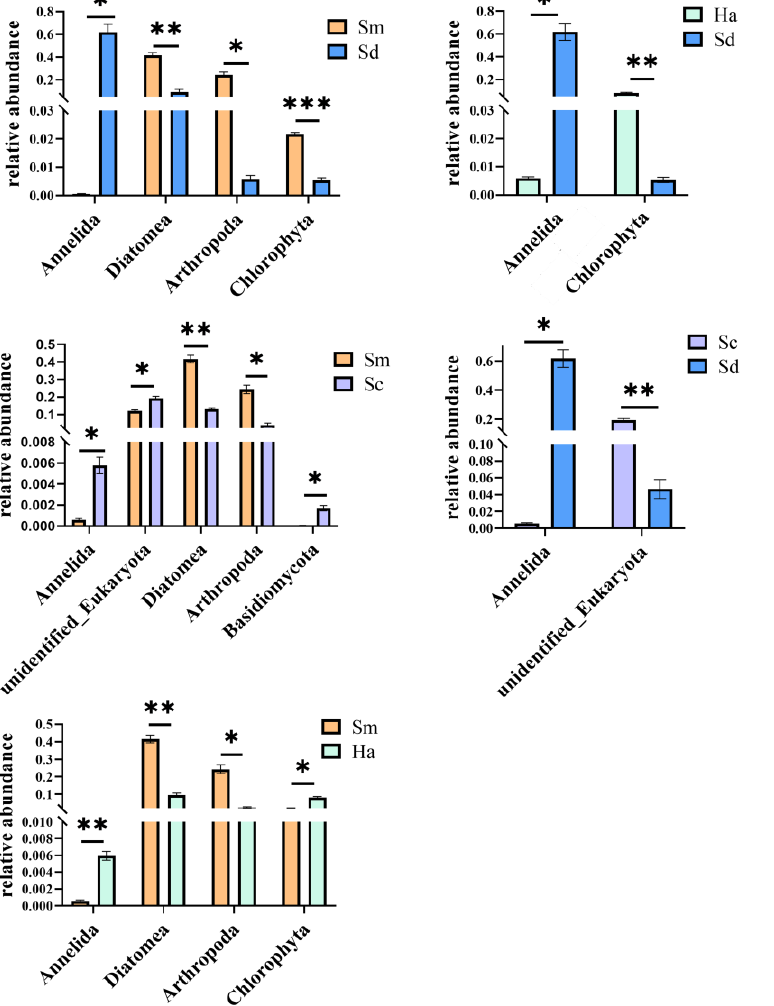
Figure 5. Identified differentially abundant taxa between samples by t -test ( p < 0.05): * p < 0.05; ** p < 0.01; *** p < 0.001.